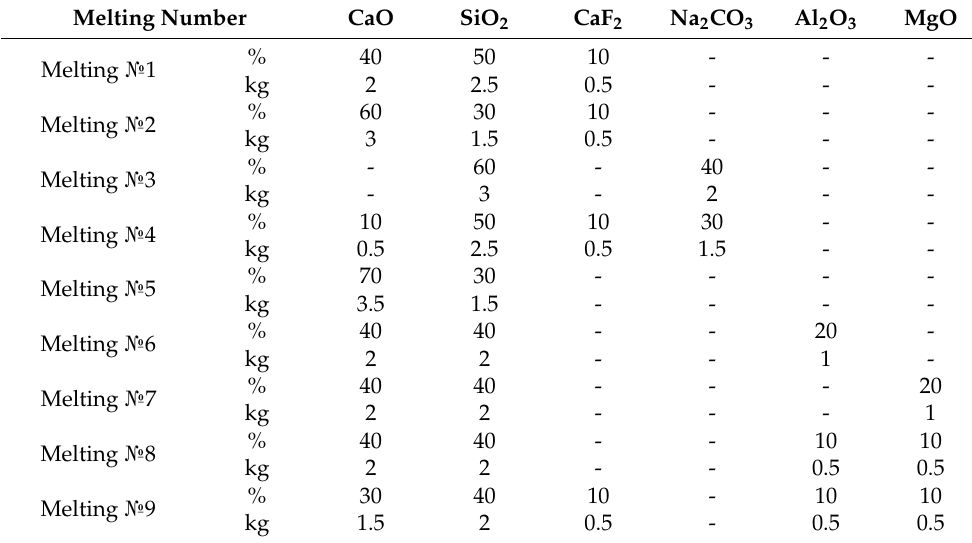
Table 2. Slag Composition for 9 slag refining processes.